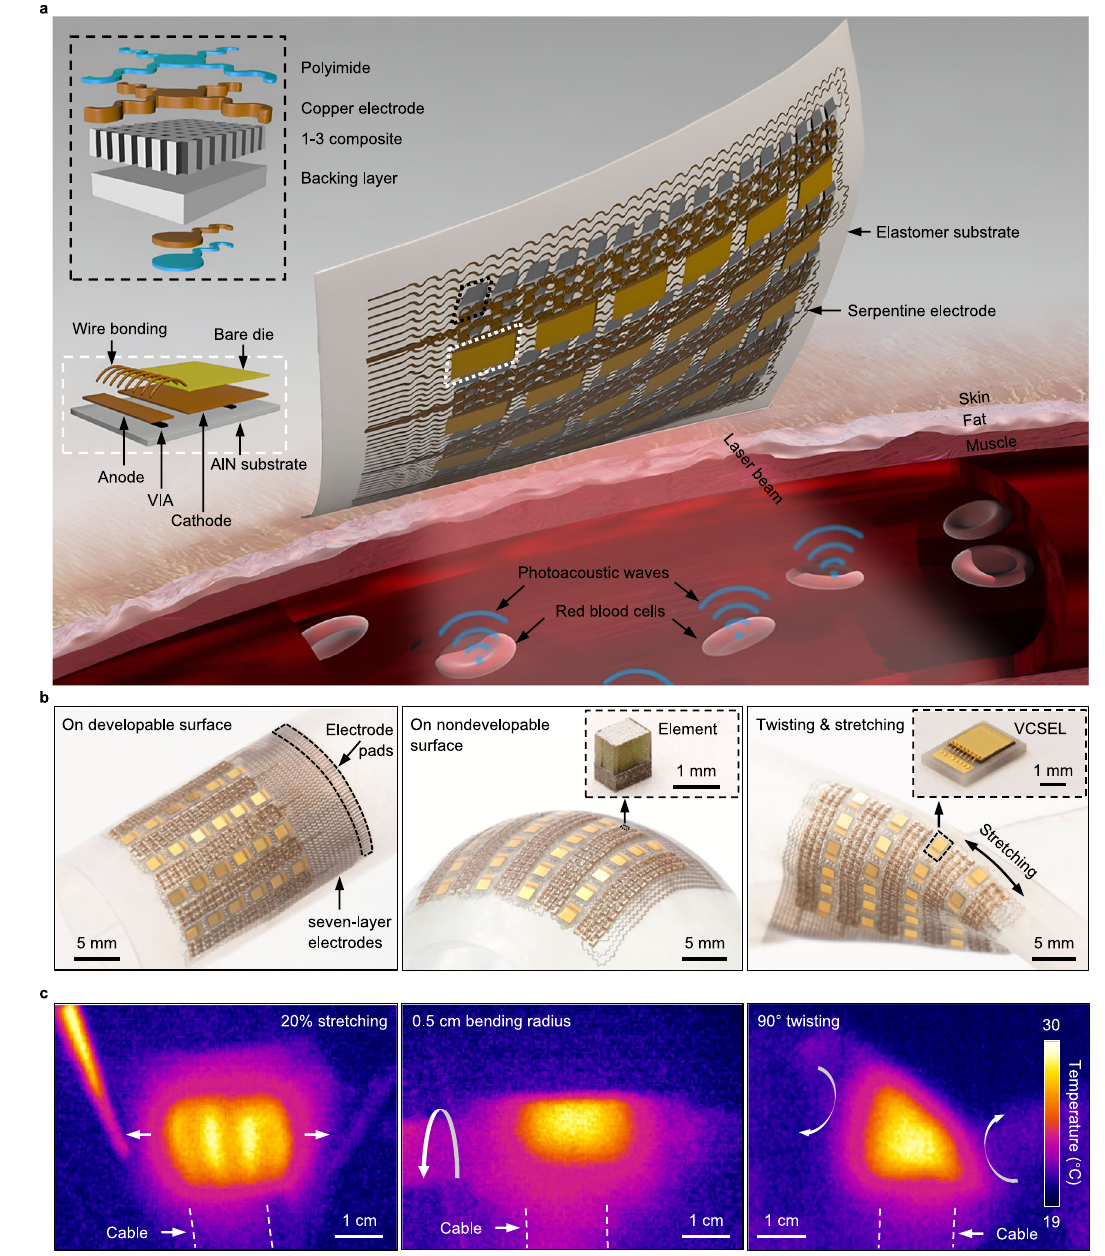
Fig. 1 | Design, fabrication, and working principle of the soft photoacoustic patch. a Schematics of the device structure and the working principle. The patch comprises an array of VCSELs and an array of piezoelectric transducers, inter- connected by serpentine copper electrodes. All components are encapsulated in Eco fl ex. Upon absorption of the optical energy, the hemoglobin molecules in red blood cells undergo thermoelastic expansion and radiate acoustic waves into the surrounding media. The photoacoustic waves will be collected by the transducer array and then relayed to a backend system for data processing. AlN: aluminum